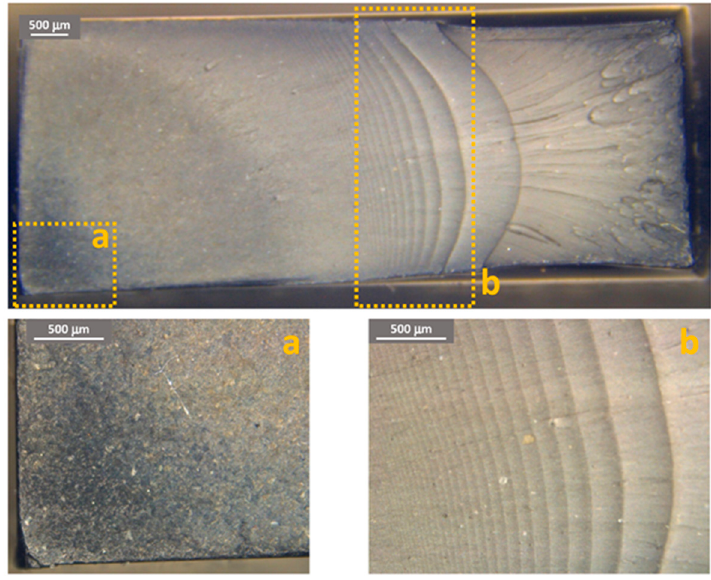
Figure 11. PC-ABS fracture surface after test at room temperature. ( a ) Crack initiation point; ( b ) propagation beach marks.